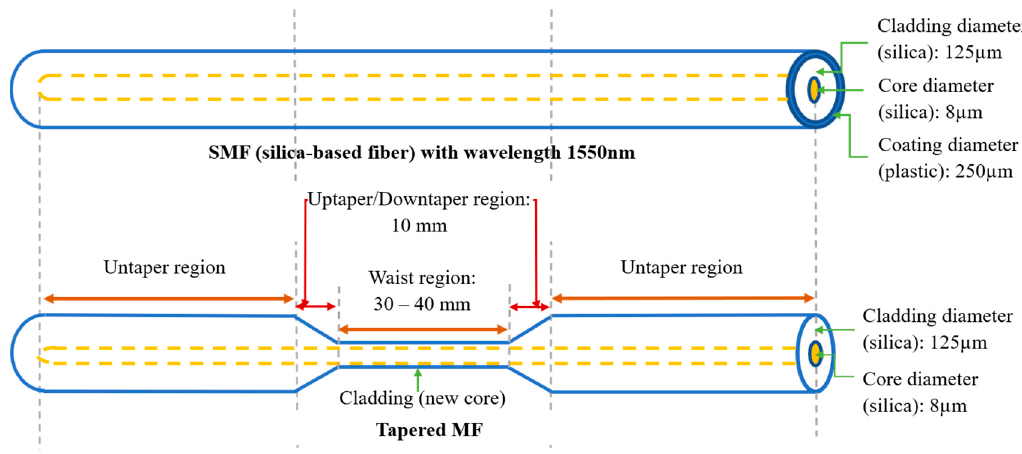
Figure 2. SMF before and after tapering process.